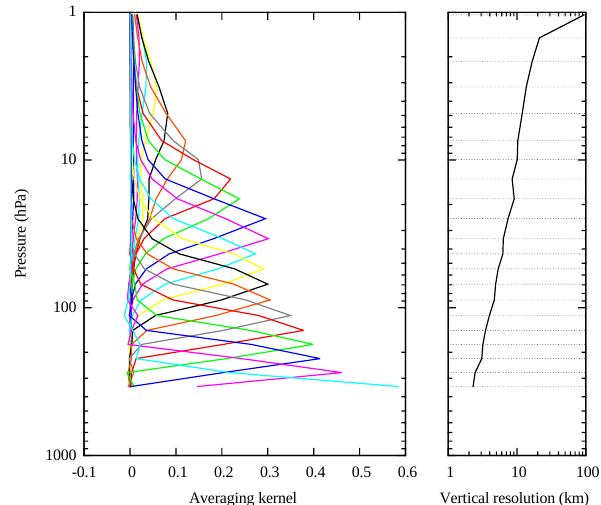
Figure 3. Typical phosgene averaging kernels (left) and vertical res- olution (right). In the left panel each colour represents a row of the averaging kernel matrix. In the right panel we have also reported the pressure levels used for the retrieval. The plots refer to the retrieval from a MIPAS limb scan acquired on 18 March 2008, 31 ◦ N/75 ◦